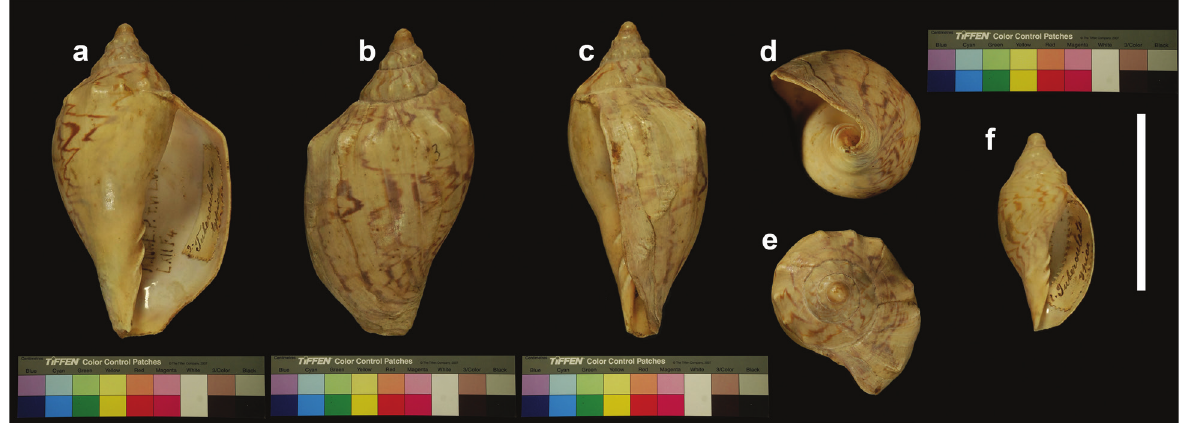
Figure 50. Voluta tuberculata typica . a–e Specimen figured by Lahille (1895: pl. VII, fig. 142; pl. XII, fig. 4) a Apertural view b Dorsal view c Lateral view d Umbilical view e Apical view f Specimen figured by Lahille (1895: pl. XII, fig. 5) in apertural view. Scale bar: 5 cm.